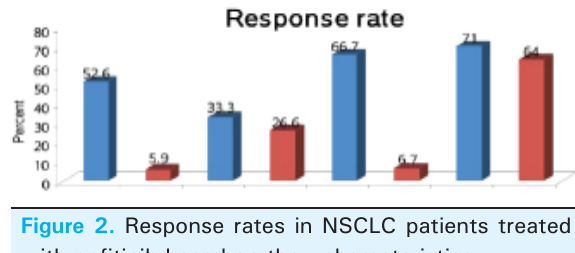
Figure 2. Response rates in NSCLC patients treated with ge fi tinib based on the